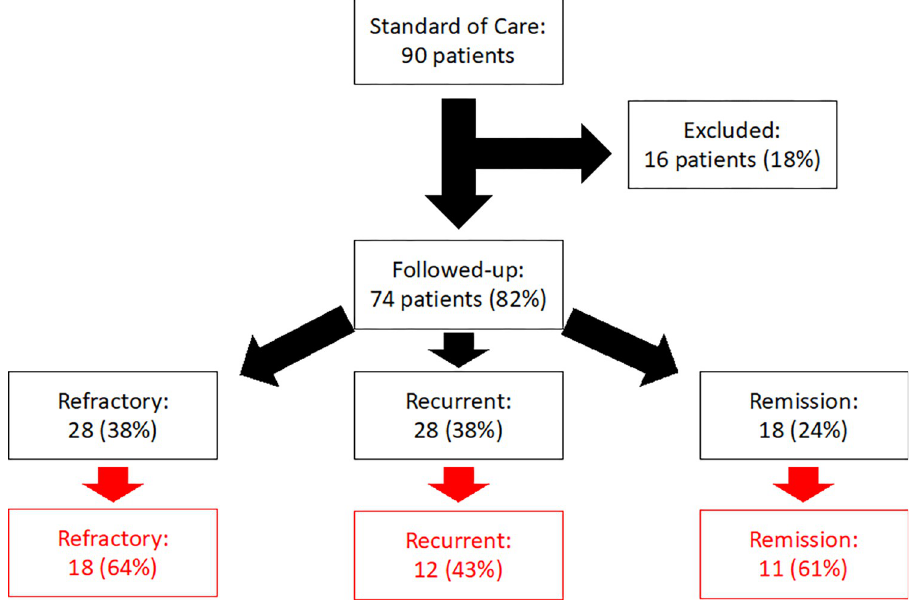
Fig 1. Patient enrollment flow diagram. This study sequenced 41 of 74 patients (represented by the red boxes) from the Akins-Sobel study [71]. Refractory patients returned to the second visit with BV symptoms and tested positive for 3 out of the 4 Amsel criteria. Recurrent patients briefly achieved remission, at the second visit, prior to recurrence. Remission patients reached clinical remission, at visit two, and were able to maintain this state for at least 3 months.